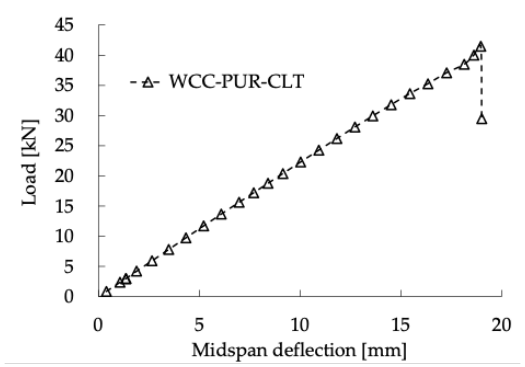
Table 2. Predictions of flexural sti ff ness.